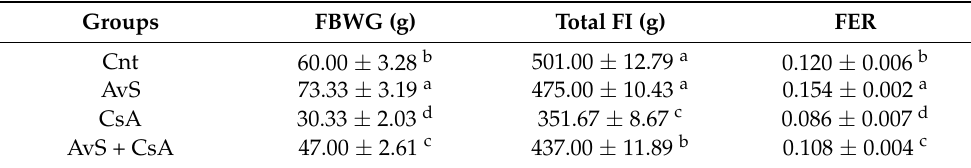
Table 4. Effects of avocado seed powder on growth-related parameters. Groups